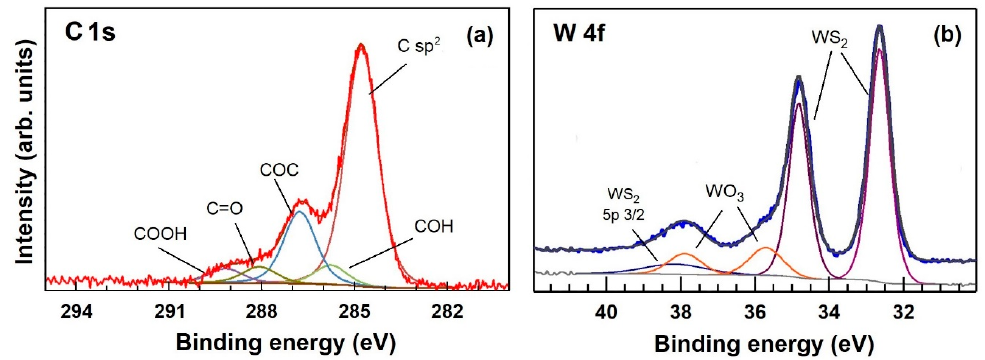
Figure 4. XPS spectra of the WS 2 -decorated rGO showing ( a ) C1s core level spectrum of rGO flakes and ( b ) W 4f core level spectrum of WS 2.